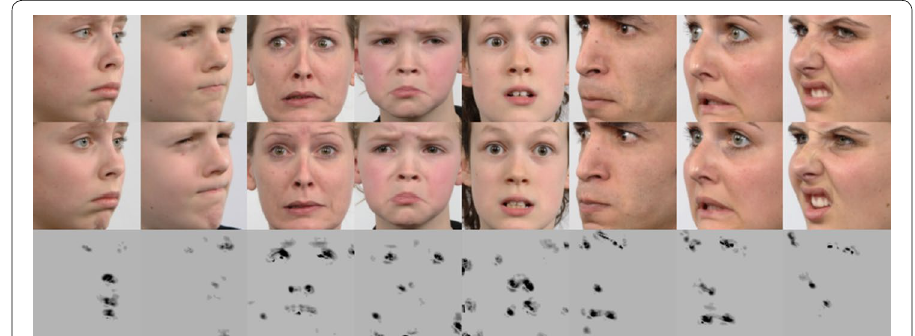
Fig. 11 Top: selected images from group A, emotions from left to right are miss-classified as: fearful, con- temptuous, neutral, angry, disgusted, sad, surprised, happy; middle: selected images from group B; bottom: facial features that lead to the miss-classifications